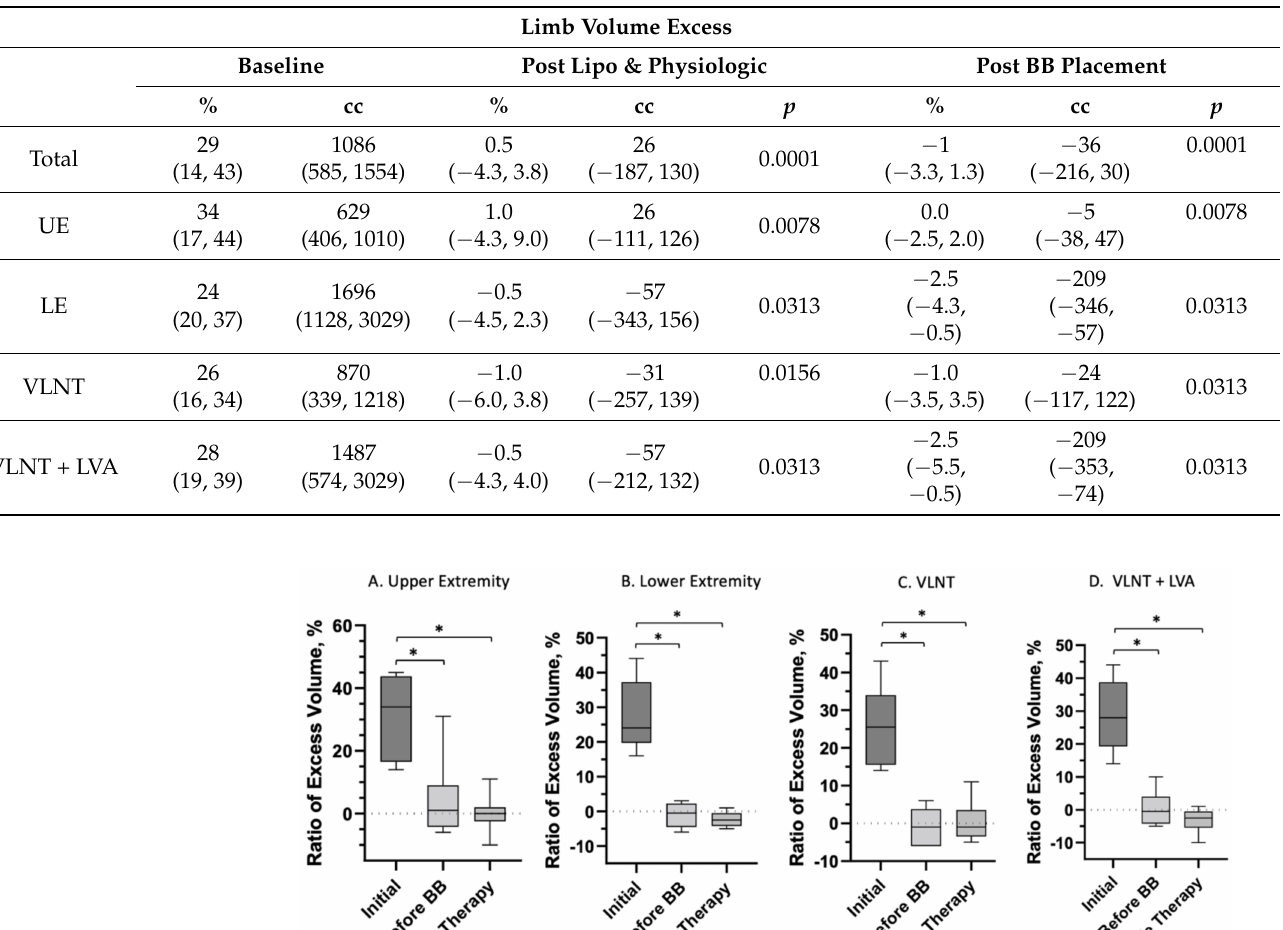
Table 3. Lymphedema limb volume excess is presented at three time points: baseline, following liposuction and physiologic surgery, and following BB placement. Data are presented in median values with interquartile range. Both percent volume excess (%) and raw volume (cc) are presented.